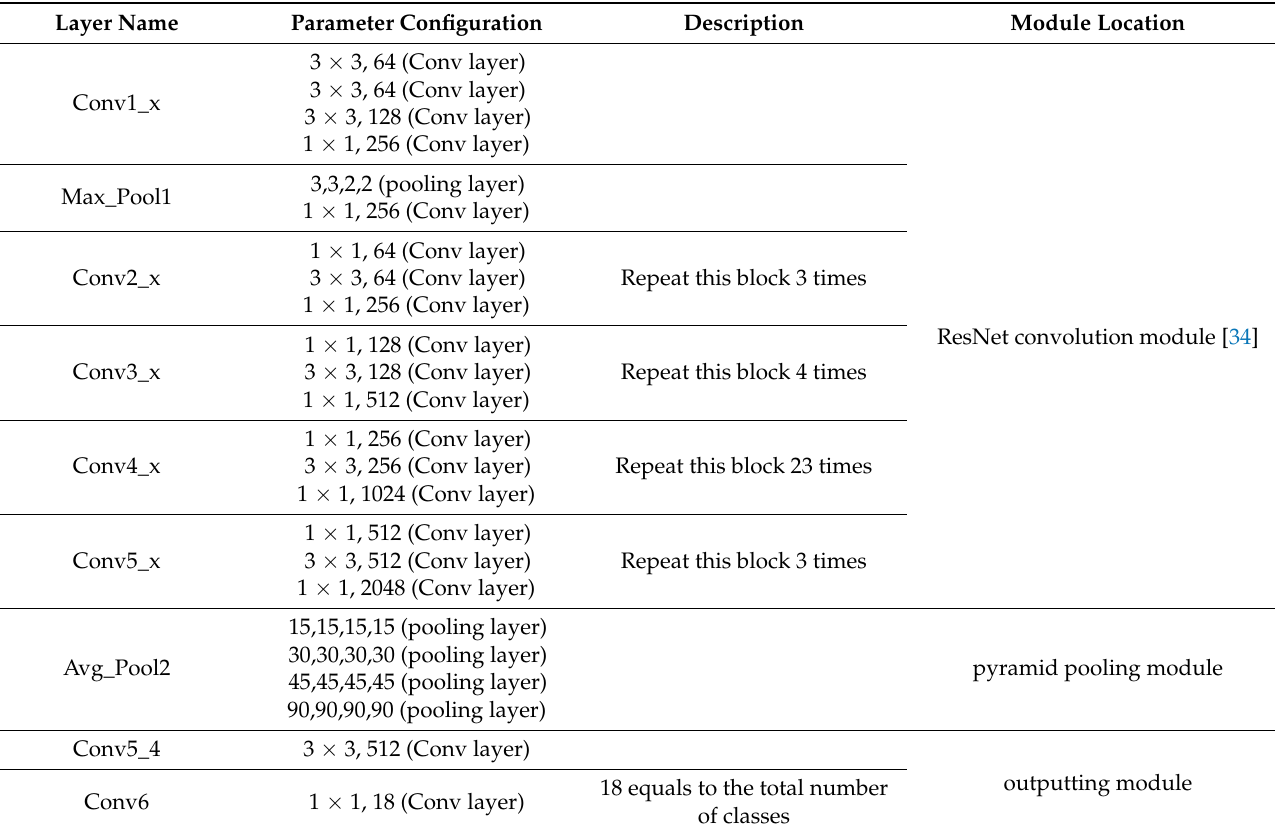
Table 3. The specific parameter setting of convolution layer and pooling layer in